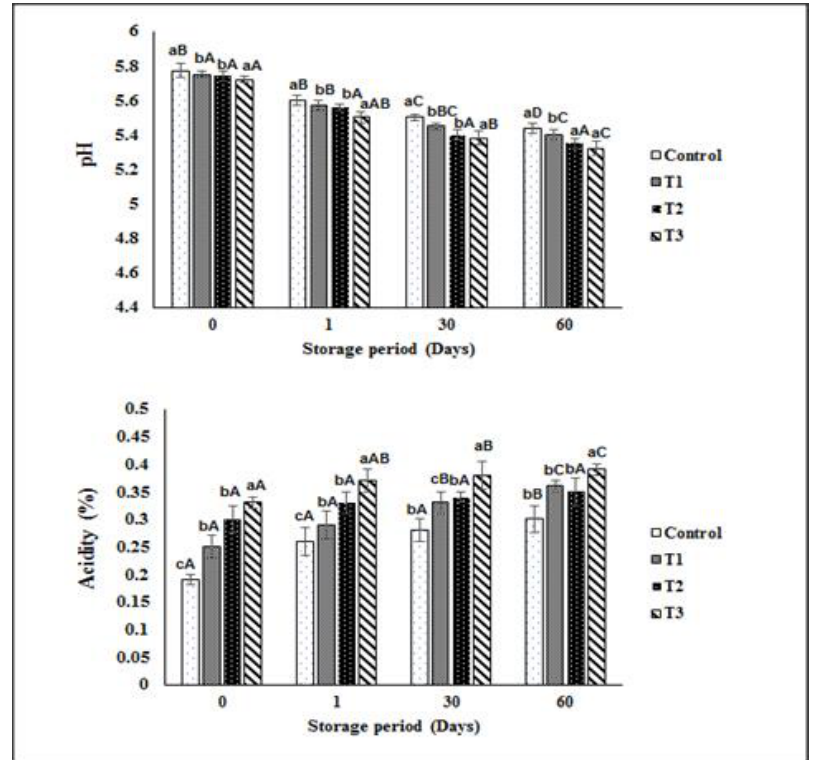
Figure 2. The pH and acidity values ice cream samples during storage periods at freezing tempera- ture. Control: ice cream made without any replacements. T1: ice cream made by replacing 25% of skim milk powder with BRP. T2: 50% replacements of skim milk powder with BRP. T3: 75% replacements of skim milk powder with BRP. Values represent the mean ± SE; n = 3 Means with various small (a–c) letter superscripts for the effect of storage time and capital (A–D) letter superscripts for the effect of different levels of BRP ( p ≤ 05).